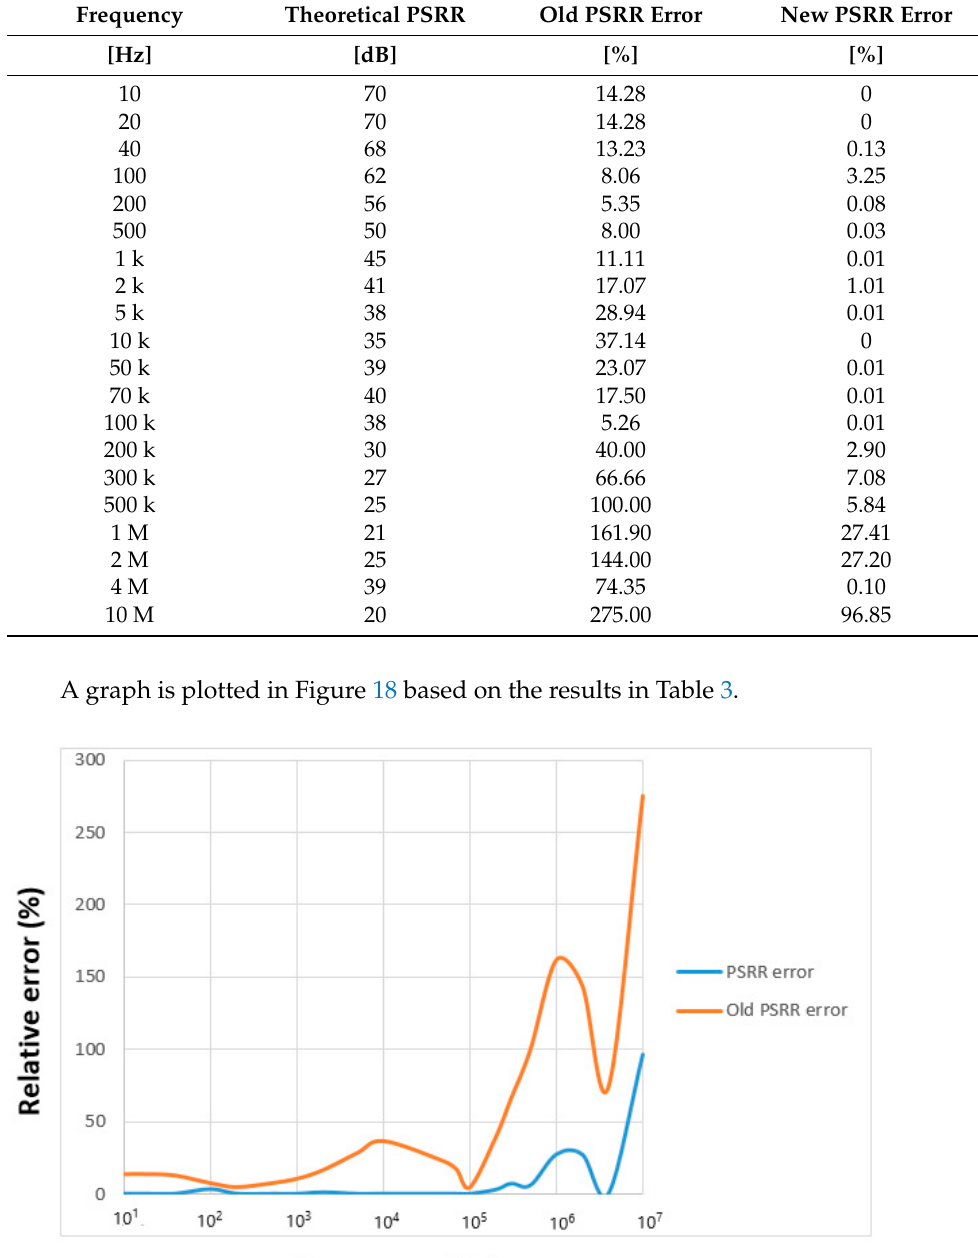
Table 3. Original PSRR error and New PSRR error vs. Frequency.